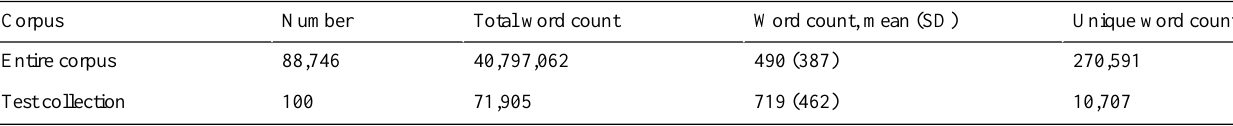
Table 3. Overview of the entire corpus and the test